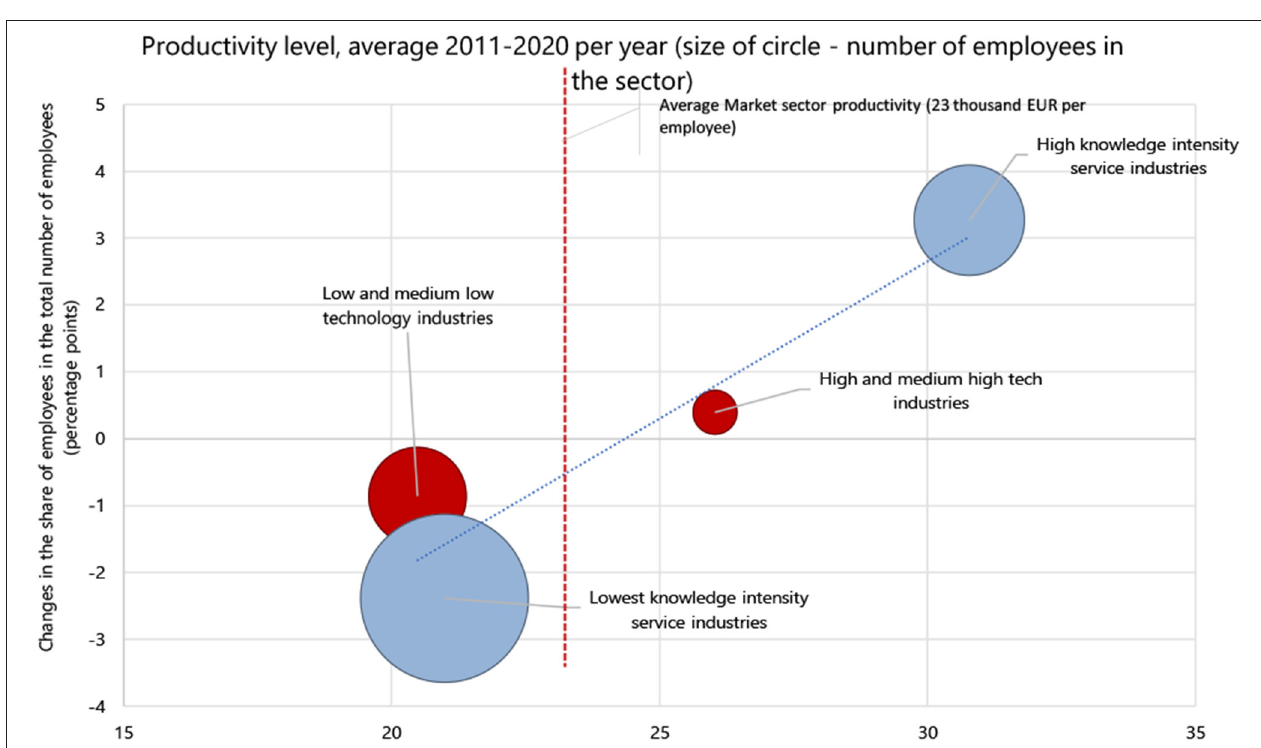
FIGURE 9 | 2011–2020 changes in the structure of employment in sector aggregated by technology levels with differing productivity levels (16). Source: author’s construction based on the Eurostat data, 2021.